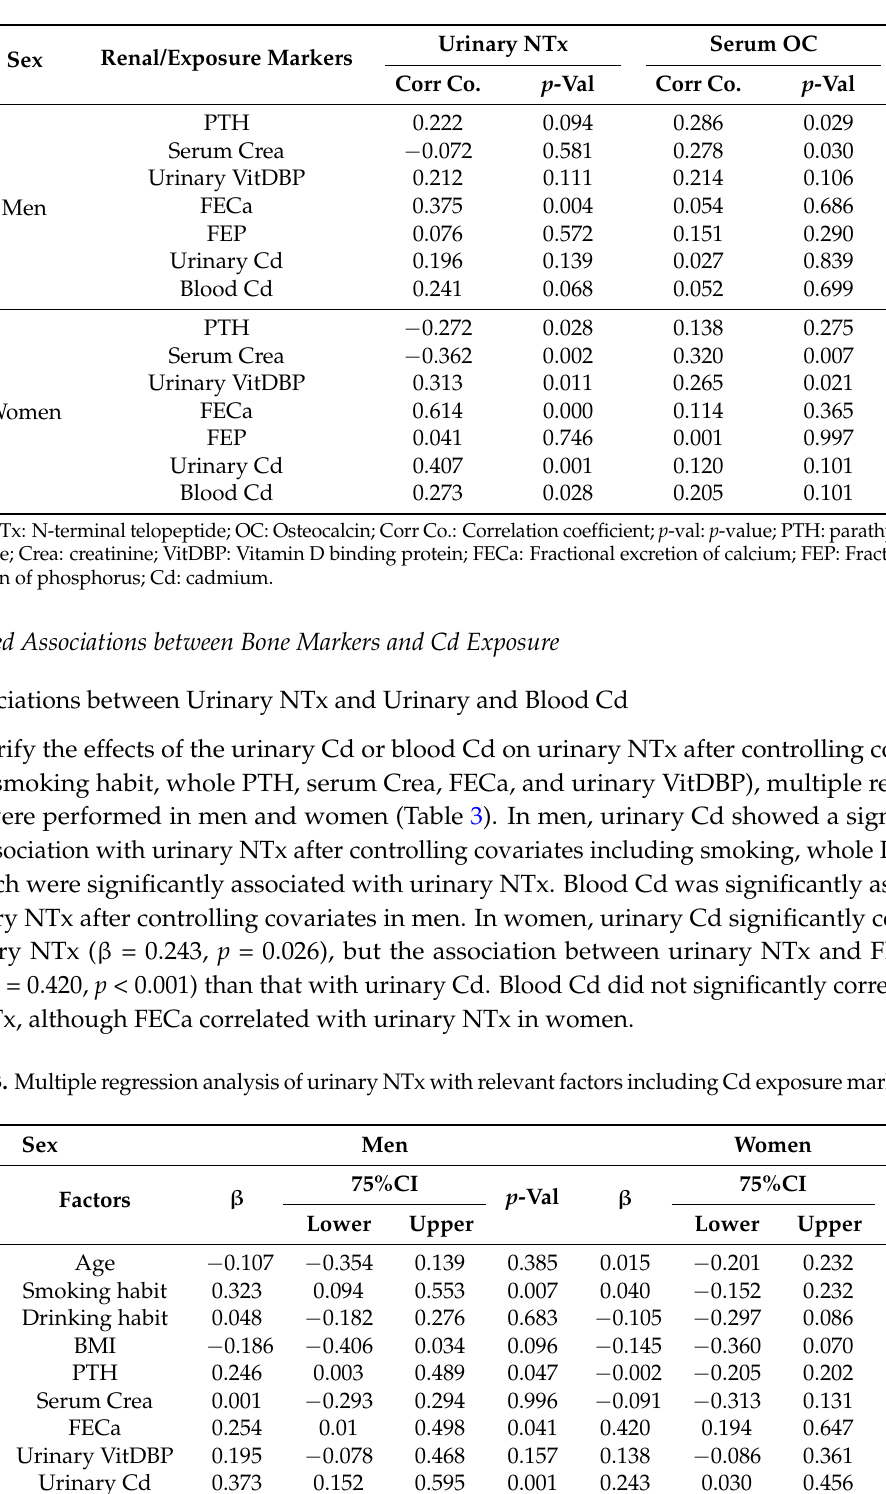
Table 2. Simple correlation analysis (Spearman’s rho) between bone markers and renal and exposure markers.